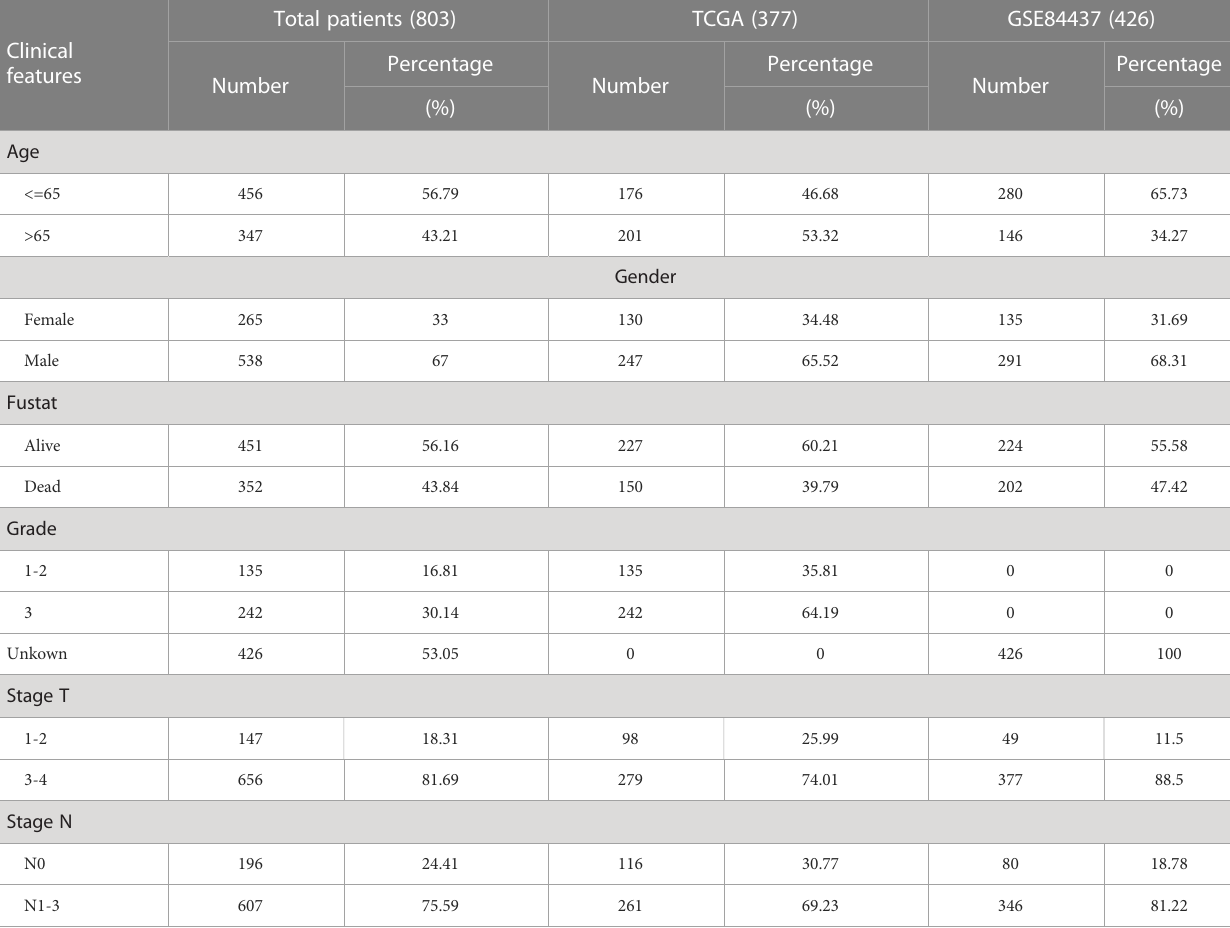
TABLE 1 Baseline characteristics of patients from TCGA and GEO